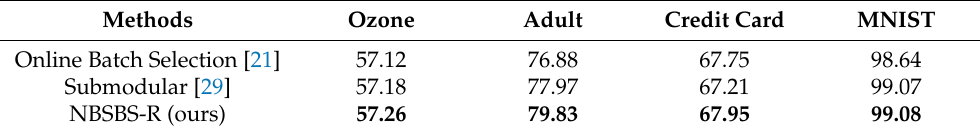
Table 10. Balanced accuracy comparison on the generalization with other online sampling